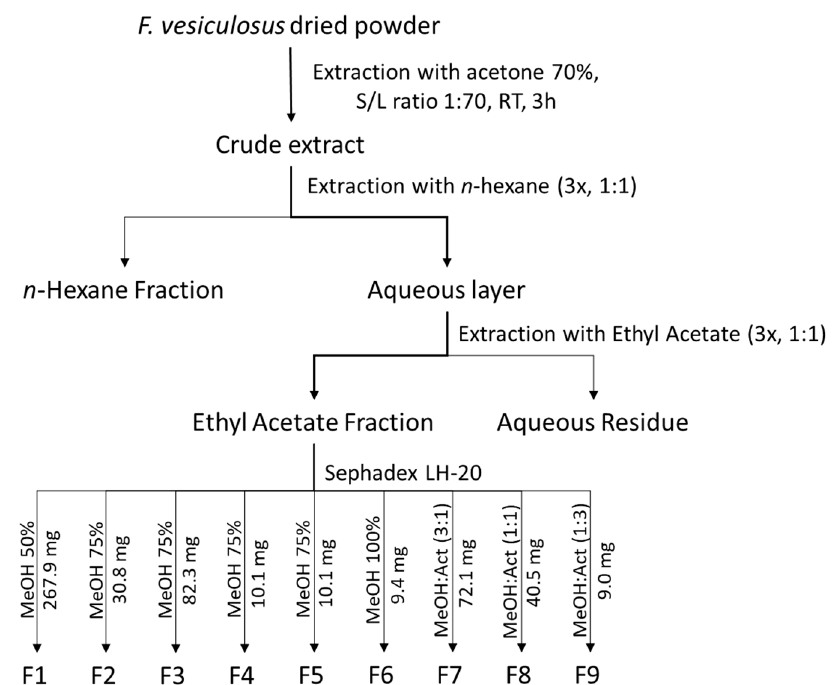
Figure 5. Flowchart for extraction and fractionation of phlorotannins from F. vesiculosus . F1 to F9 represent nine subfractions obtained from the Sephadex LH-20 column chromatography with a solvent system of decreasing polarity. S / L—solid / liquid ratio (g / mL), RT—room temperature, MeOH—methanol, Act—acetone.